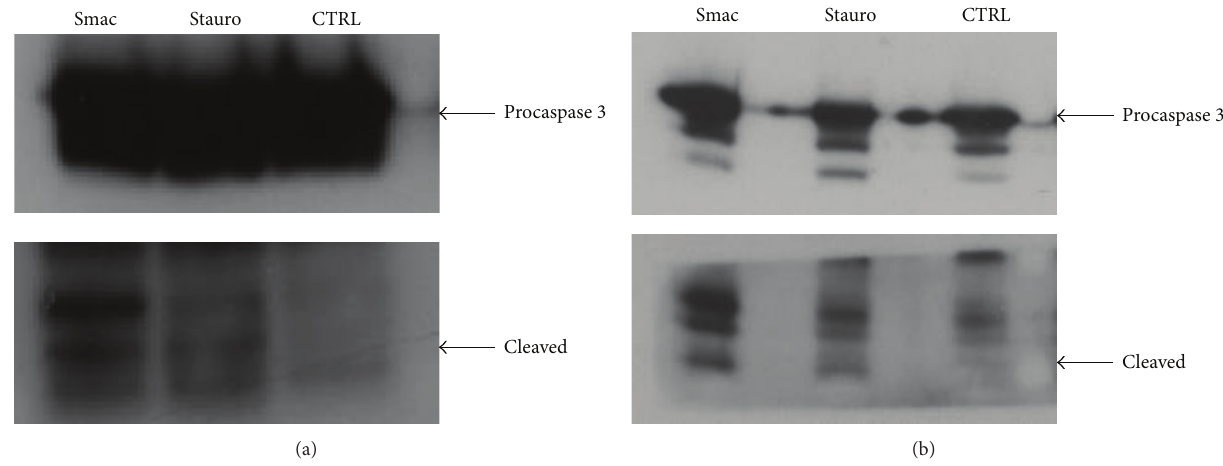
Figure 5: Smac127 induces caspase 3 activation. Western blot analysis shows the effect of Smac127 on caspase 3 in extracts from human fibroblast-like synoviocytes (FLSs) derived from patients with rheumatoid arthritis cultured in TM (a) or in SF for 5 days (b). Levels of cleaved caspase 3 were measured in RA-FLSs untreated (CTRL) or treated with Smac127 (15 𝜇 M) or treated with the apoptosis inducer staurosporine (stauro). Cells cultured in tissue medium alone were incubated for 6hrs, whereas cells grown in the presence of SF were incubated for 18 hrs; staurosporine 20 𝜇 M was the positive